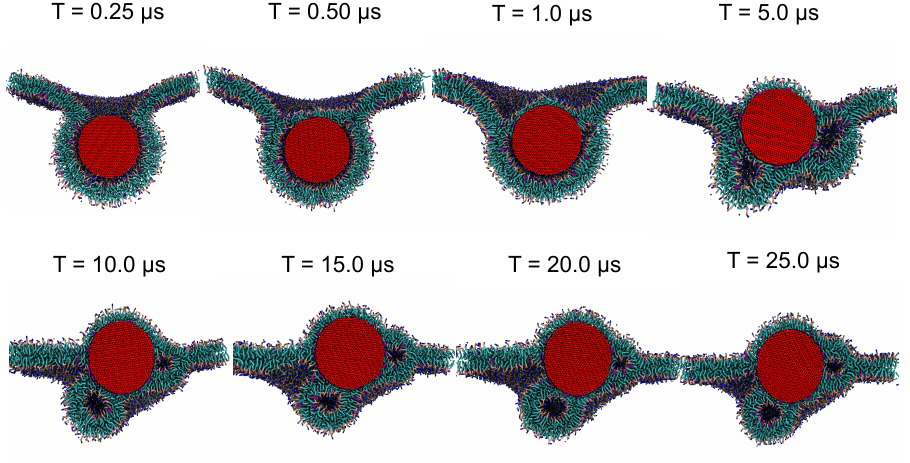
Figure 10. Simulation snapshots of the evolution of a 10 nm Ag CG NP interacting with a lipid membrane composed of DPPC, DOPC, POPC and cholesterol in 5:2:2:1. As the nature of the lipids is not crucial at this stage, all the lipids are shown in stick representation and cholesterol as a pink stick, while each NP CG bead is shown as a red